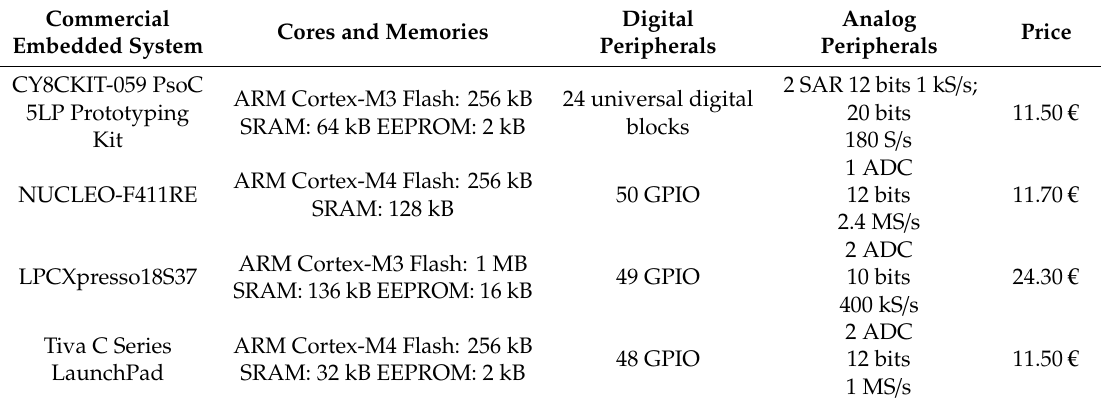
Table 1. Technical-economic characteristics of four commercial embedded